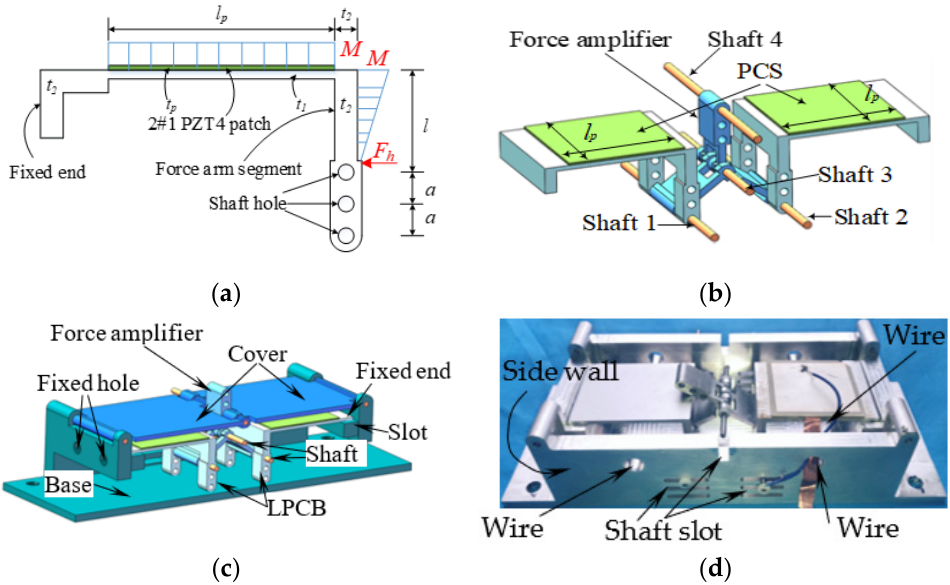
Figure 1. 1# piezoelectric brick made of a pair of LPCBs with one PCS. ( a ) A section view of an LPCB; ( b ) An assembly diagram; ( c ) A section view of 1# piezoelectric brick; ( d ) An experiment specimen of a piezoelectric brick.